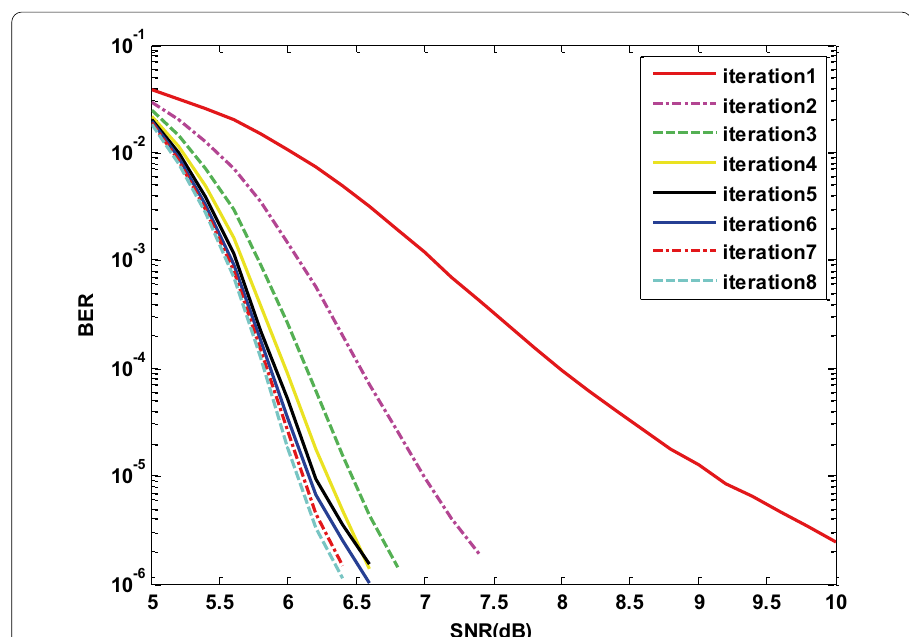
Fig. 6 BER of the BICM scheme composed of 16 QAM modulation and DBTC of rate 1/2. The BER curves from 1 to 8 iterations obtained for a 16 QAM modulation associated with the DBTC of rate 1/2, over a Gaussian